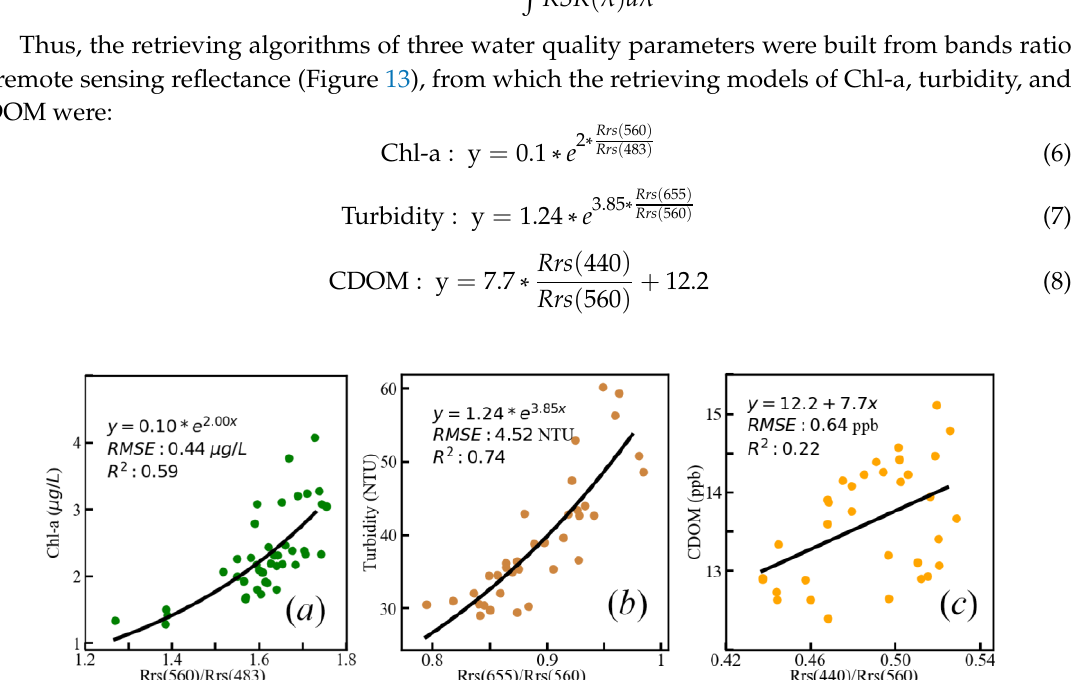
Figure 12. Statistics of Chl-a, turbidity, and CDOM in the deployment site (Figure 7) from July 20, 2013, to July 28, 2013.